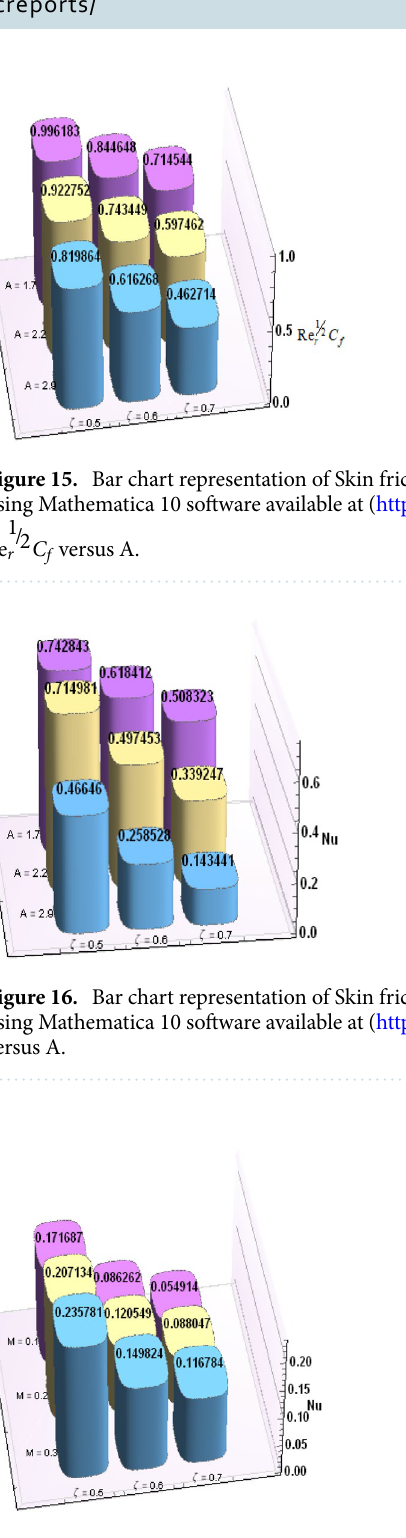
Figure 17. Bar chart representation of Skin friction coefficient and Nusselt number for different parameters using Mathematica 10 software available at (https:// softa sm. com/ wolfr am- mathe matica- 10-4- full- crack/). Nu versus